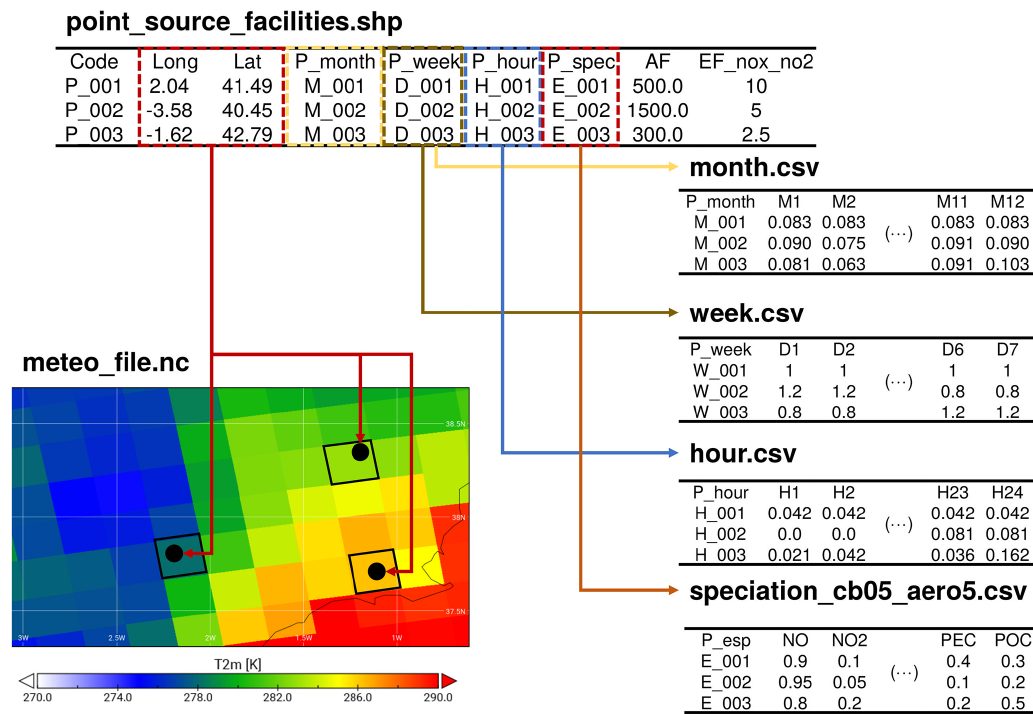
Figure 2. Illustration of how the different input files used by the point source sector are linked and cross-referenced. The multipoint shapefile (point_source_facilities.shp), contains temporal and speciation profile IDs for each facility (e.g. “MXXX” for the monthly profiles, “XXX” being a three-digit numeric code that starts at “001”), which are cross-referenced with the corresponding temporal and speciation CSV files (month.csv, week.csv, hour.csv, speciation_cb05_aero5.csv). The shapefile also contains the geographical coordinates of each facility (long, lat), which are used to identify the closest grid cell of the meteorological NetCDF file (meteo_file.nc) and derive the surface temperature